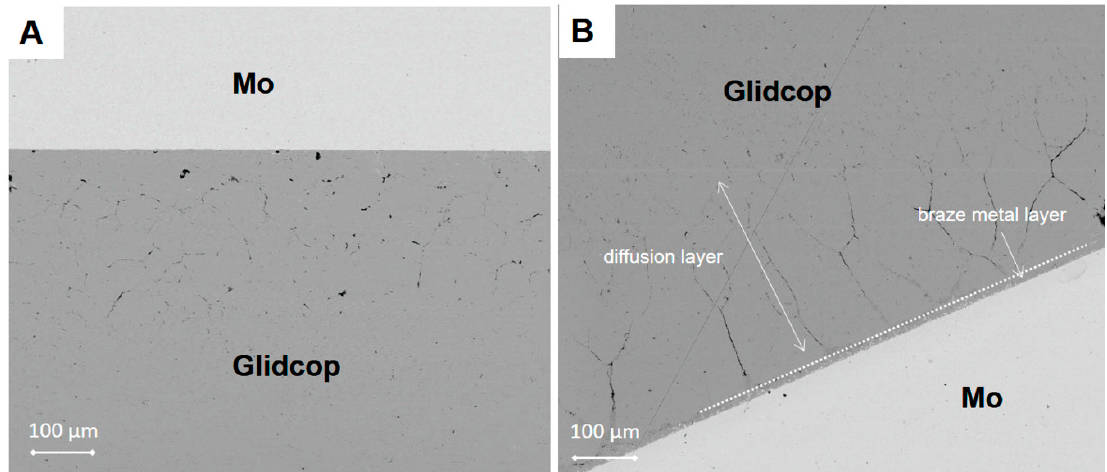
Figure 5. SEM micrographs of the cross-section of a Glidcop/Mo interface obtained by means of brazing (three Gemco braze foils) at 980 °C for 5 min ( A ) and for 30 min ( B ) under flowing Ar and applying 0.02 MPa.